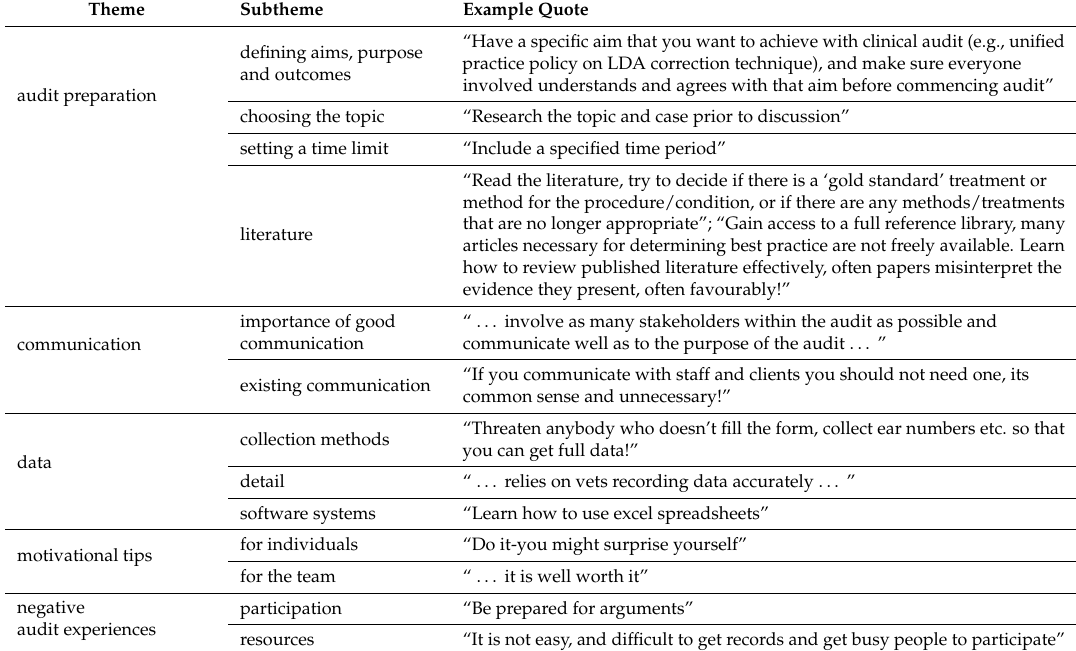
Table 3. Main themes identified from advice that veterinary surgeons who have set up and run clinical audits previously nominated they would give to other veterinary surgeons wishing to set up clinical audits. Taken from a survey investigating the experiences and attitudes of UK farm animal clinicians towards clinical